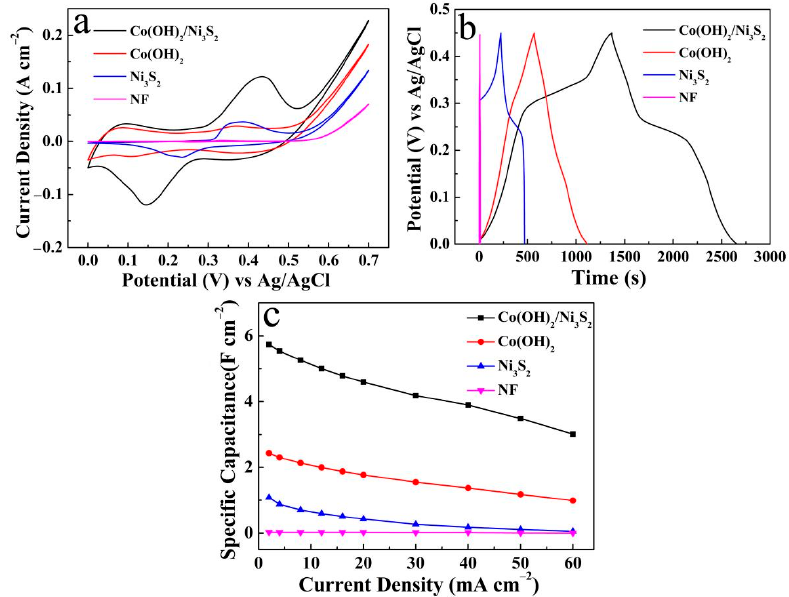
Figure 4. Performance comparison of Co(OH) 2 /Ni 3 S 2 , Ni 3 S 2 , Co(OH) 2 and NF electrodes: ( a ) CV curves, ( b ) GCD curves and ( c ) C s at different current densities.